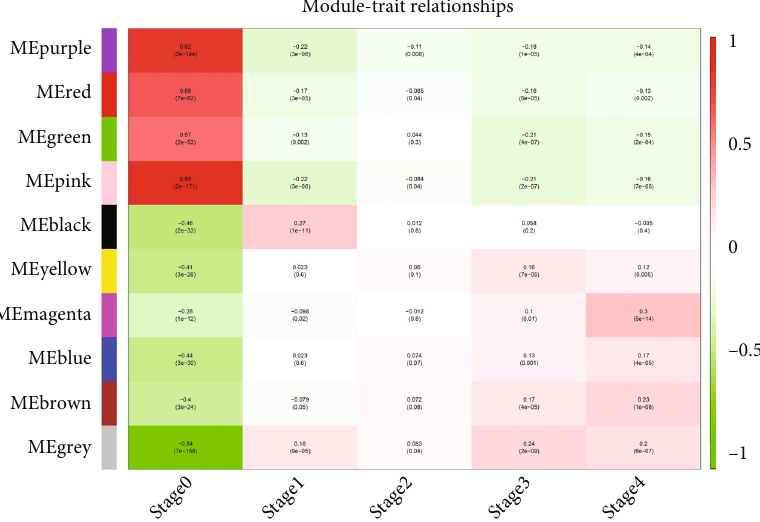
Figure 3: Common module eigengenes and module-clinical signature relationships at di ff erent stages of KIRC. The chart rows correspond to di ff erent ME, and the columns correspond to clinical parameters. The cell numbers indicate the corresponding correlation and p values. Colors of each cell were fi lled based on correlation and the color legend. The strength and direction of the correlation are shown in the heatmap on the right panel. ME: module